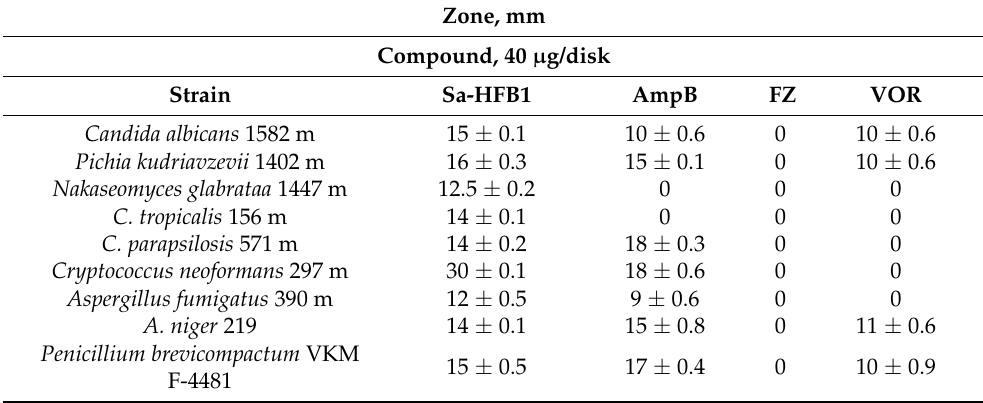
Figure 10. Alignment of the hydrophobin’s amino acid sequences. The alignment shows an E to D amino acid replacement at position 29 in the mature hydrophobin sequence (amino acids 1–30 are signal peptides). Table 1. The activity of purified Sa-HFB1 on the growth of opportunistic and clinical pathogenic fungi isolates measured by a disk diffusion